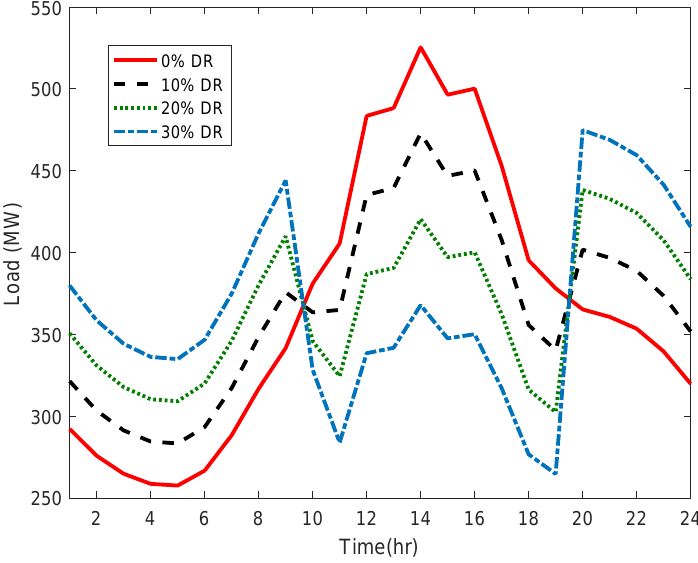
Figure 6. The ower demand after the demand response (DR)